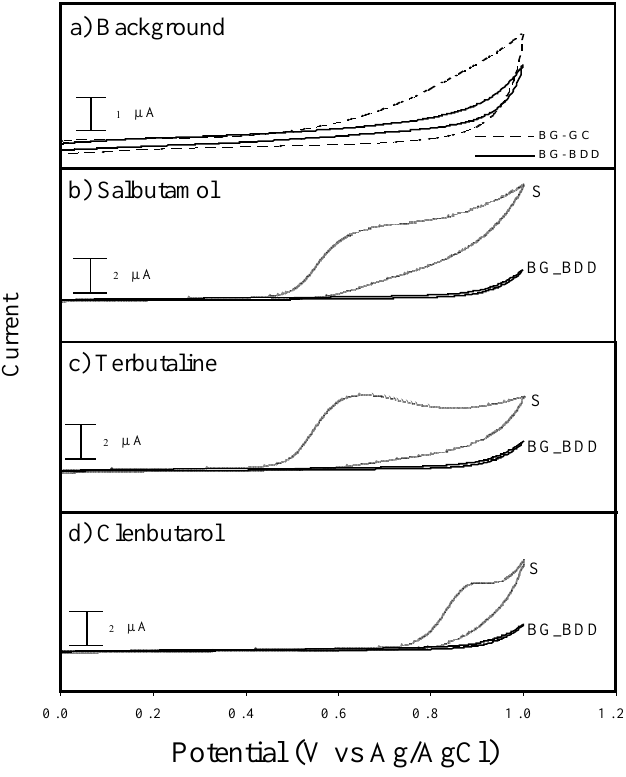
Figure 3. Background (BG) and signal (S) voltammograms obtained from 1 mM standard solutions of salbutamol, terbutaline and clenbuterol. Working electrode: BDD or GC. Auxiliary electrode: Pt. Buffer: 50 mM Tris buffer pH 8.3. Scan rate was 100